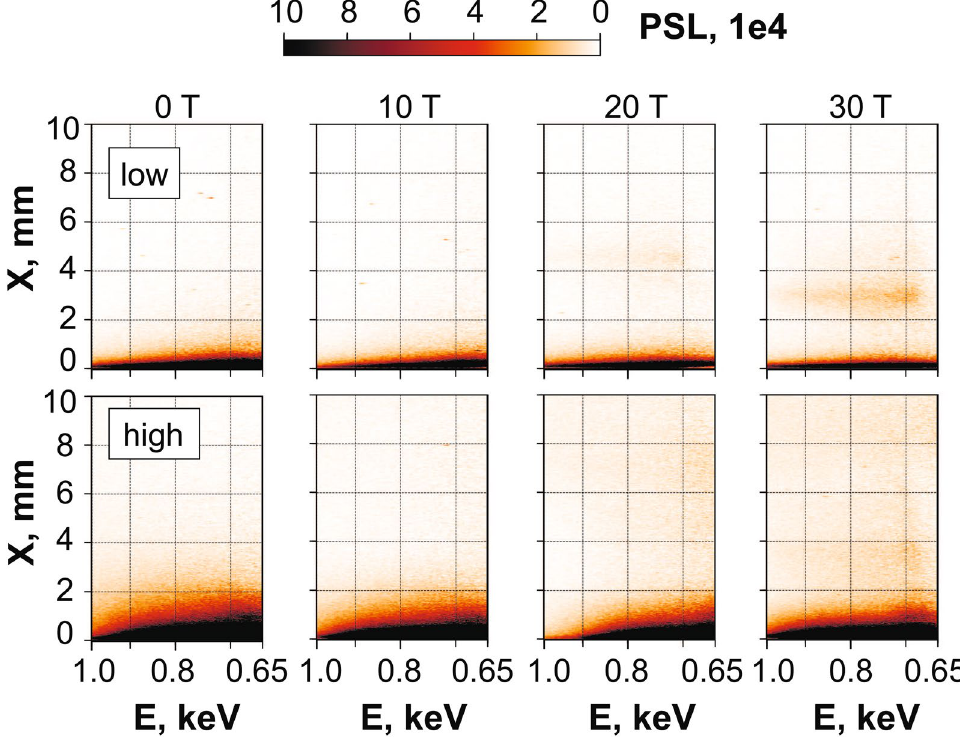
Figure 9. (Top) VSG X-ray images (in PSL) for a laser-induced plasma immersed into a magnetic field of 10 12 W/cm 2 on the target. (bottom) The different strengths 0–30 T and when the laser intensity is about 2 × 10 13 W/cm 2 same but for the laser intensity of 4 ×